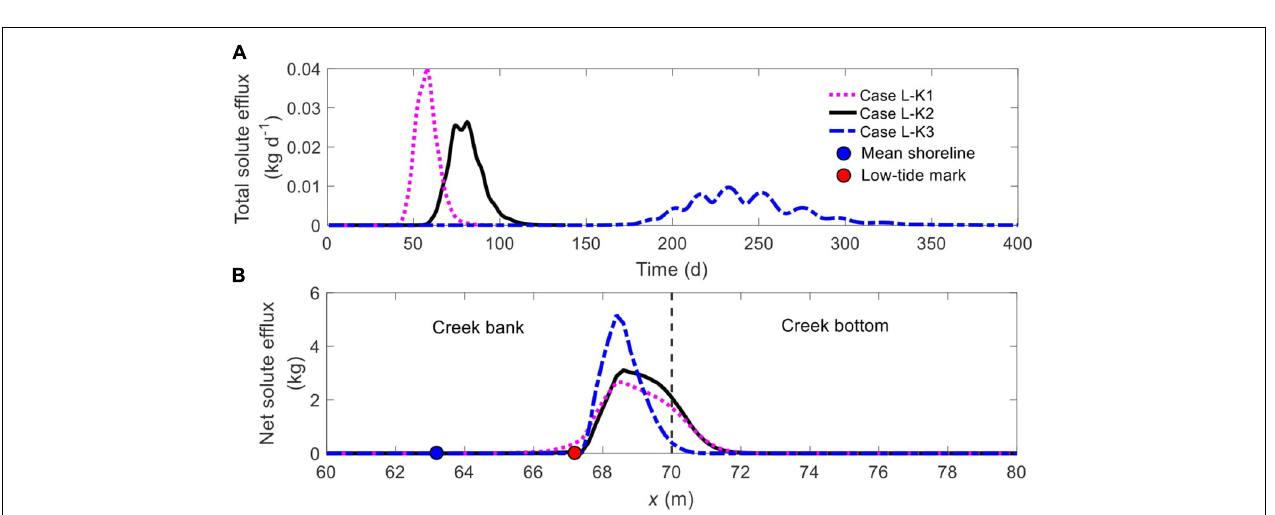
FIGURE 6 | Comparison of (A) horizontal variance and (B) vertical variance between Cases H and L. The plume edge was determined based on the concentration of 0.0001 C 0 .